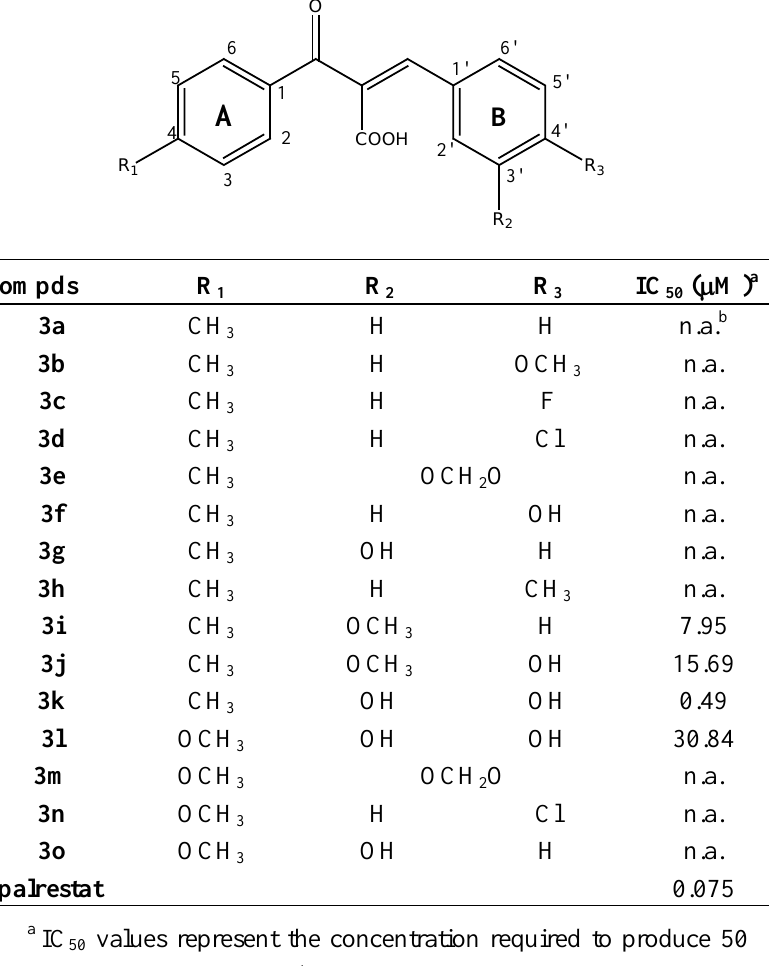
Table 1. In vitro rat lens aldose reductase inhibition data of ( Z ) - 3-phenyl-2-benzoyl- propenoic acid